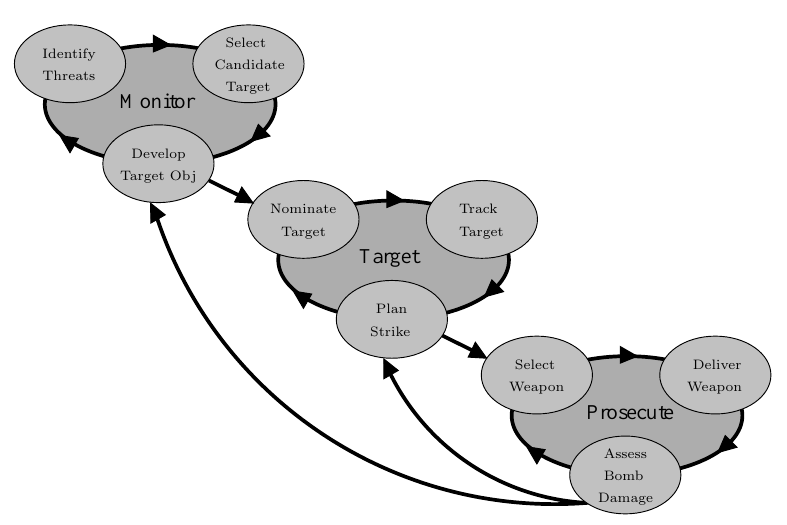
Figure 2: A number of OODA loops in parallel